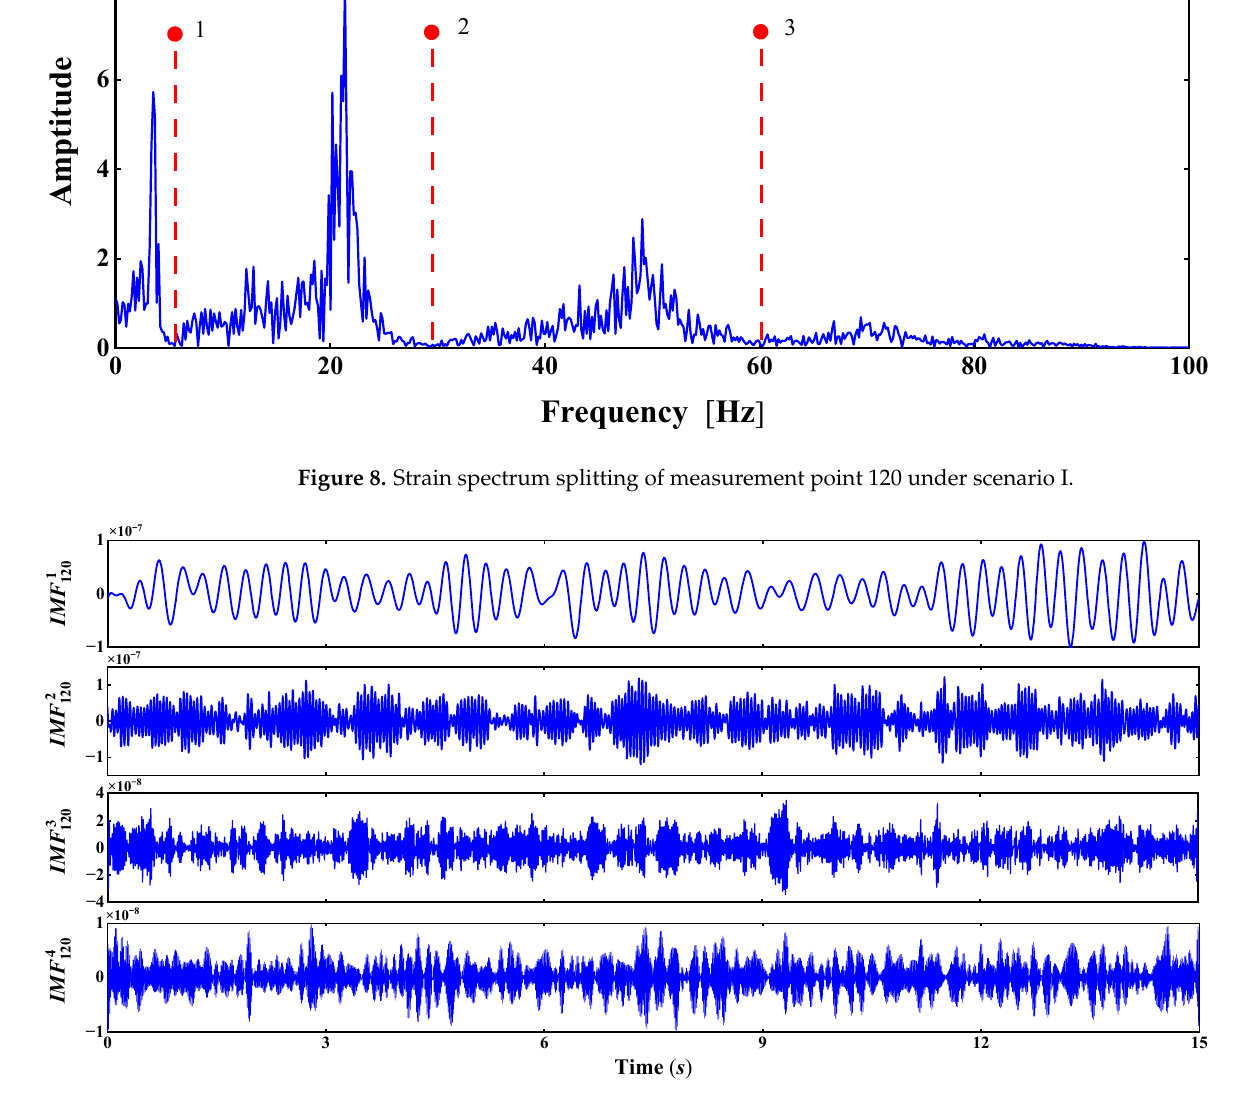
Figure 9. The first four IMF components of measurement point 120 under scenario I. The IMF i acquired by EWT can be substituted directly into Formula (17) to obtain SSSM i . Repeat the above operation for each measurement point to obtain the SSSM i of the i th order under scenario I. Figure 10 shows the first four SSSM orders of the cracked cantilever beam in scenario I and II, from which it can be seen that the SSSM curve has a smaller abrupt change at the damage, especially in the multi-damage scenario (scenario I), where the damage severity is small. The direct observation of the SSSM curve is not convenient for judging all the damage locations visually; moreover, it may be misjudged under the influence of uncertainty factors such as noise. To solve this problem, CWT is used to amplify the mutation caused by the damage, and the averaging operation is applied to fuse the damage information in the multi-order SSSM curves, the three-sigma rule is introduced to construct the damage index SSSM DI for the simultaneous identification of multiple damages in the cracked cantilever beams in the